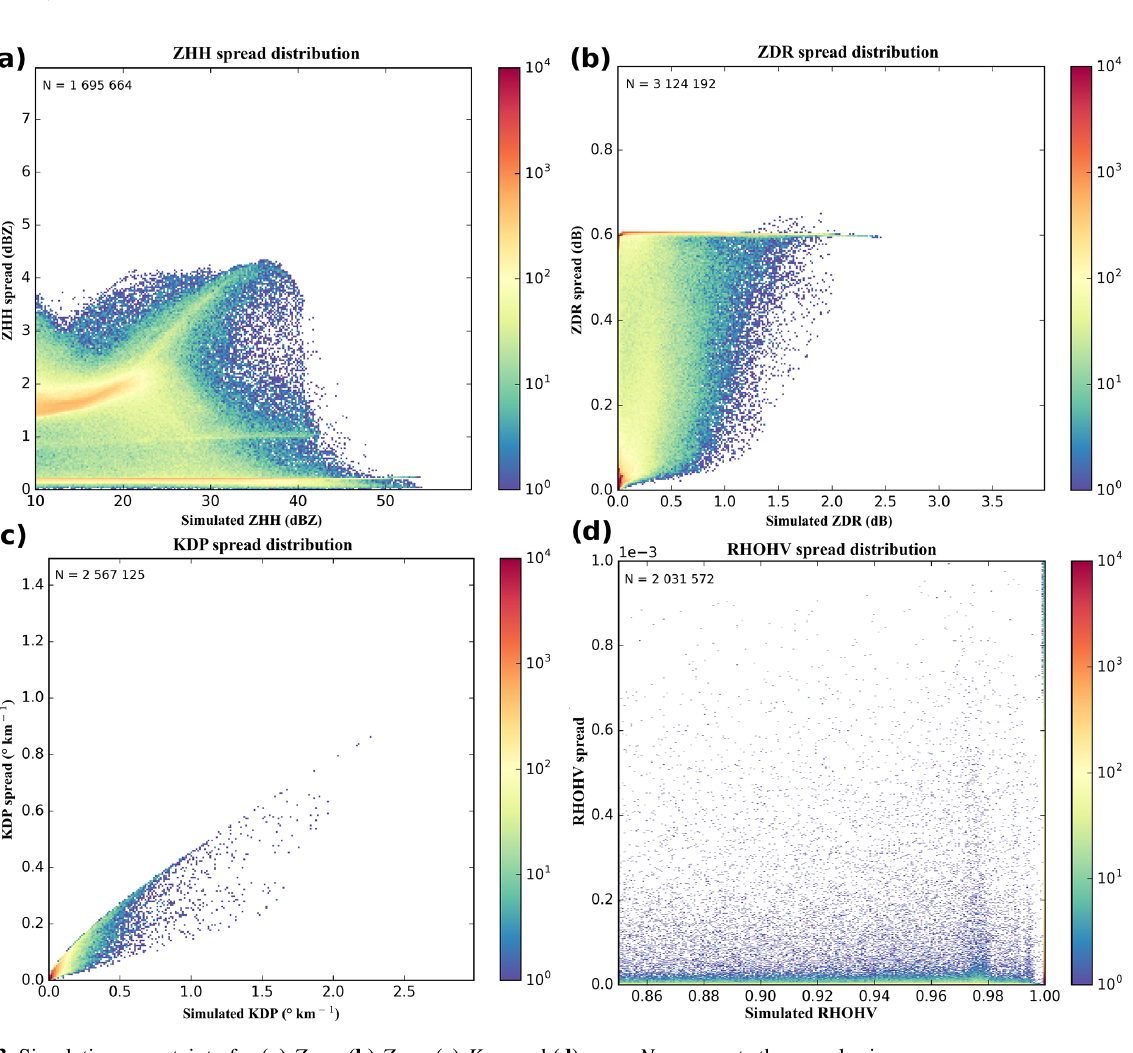
Figure 3. Simulation uncertainty for (a) Z HH , (b) Z DR , (c) K DP and (d) ρ HV . N represents the sample